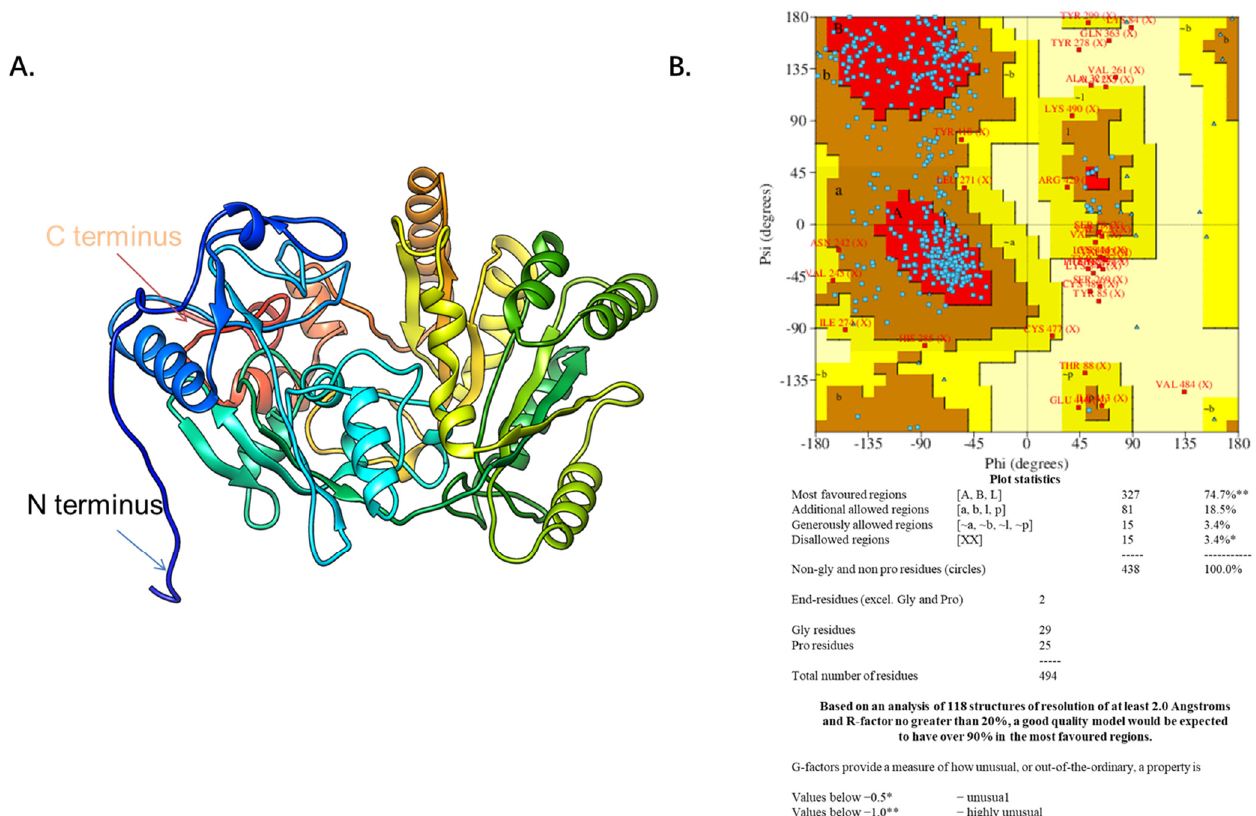
Figure 1. The predicted DHCR24 structure and evaluation. ( A ). The DHCR24 model. ( B ). The Ramachandran plot of modeled structure was validated by the PROCHECK program. The red area indicates the most favored regions of amino acid residues, the brown area indicates the additional allowed regions, and the yellow area indicates the generously allowed regions. The Ramachandran plot of protein contained 96.6% of residues in the favored and allowed regions, indicating a good quality model for the protein. Table 1. LGscore, Maxsub, VERIFY3D, and Ramachandran plot score of the DHCR24 models.